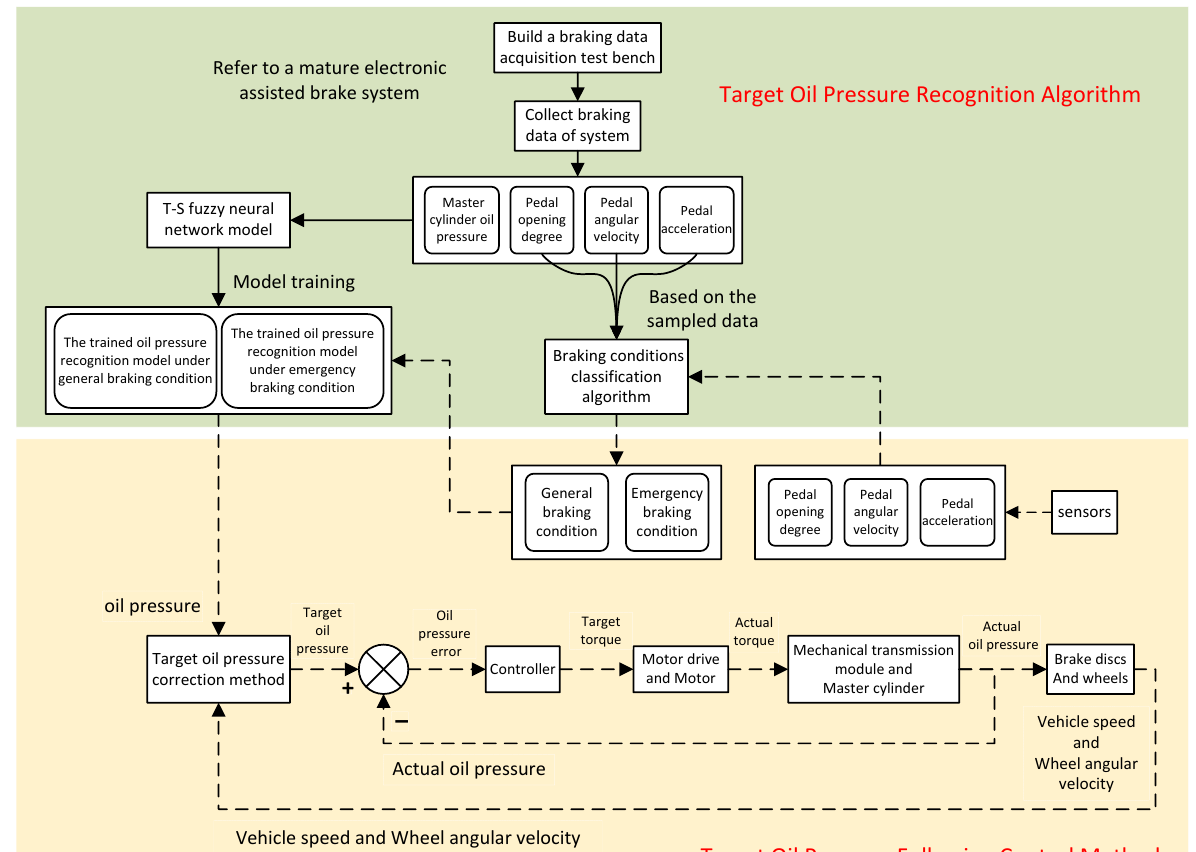
Figure 2. The framework of research